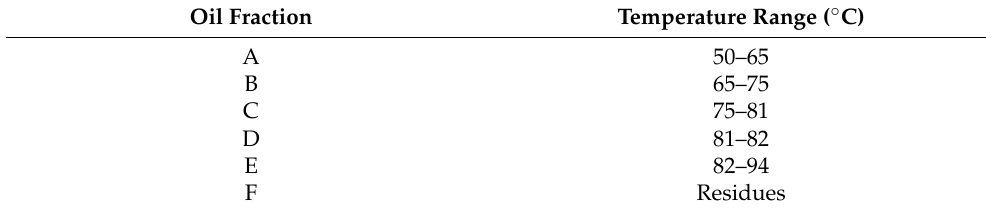
Table 1. Temperature conditions for the fractionation of the essential oil of P. koraiensis wood.